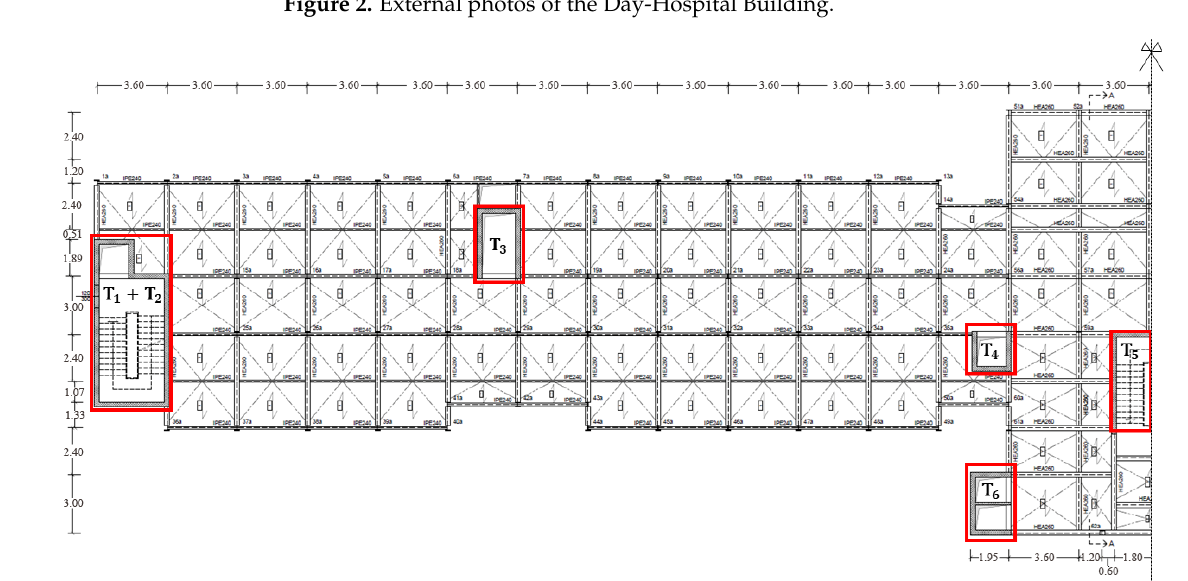
Figure 3. Left half of the carpentry plan of the Day-Hospital Building.